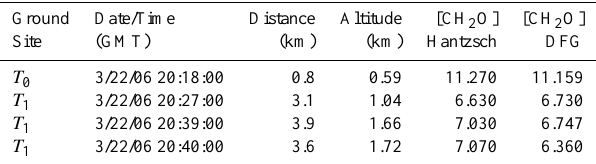
Table A2a. C-130 (DFG) and ground-based (Hantzsch) compar- isons of ambient CH 2 O over Mexico City. The distance is the air- craft distance to the site and the altitude is the height above ground from the aircraft radar. The mixing ratios are in